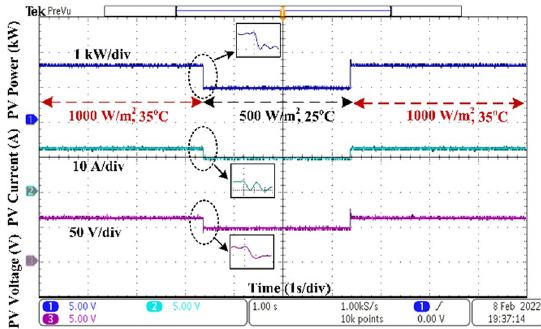
Fig. 27 PV voltage, power and current response for the proposed method in the presence of changing